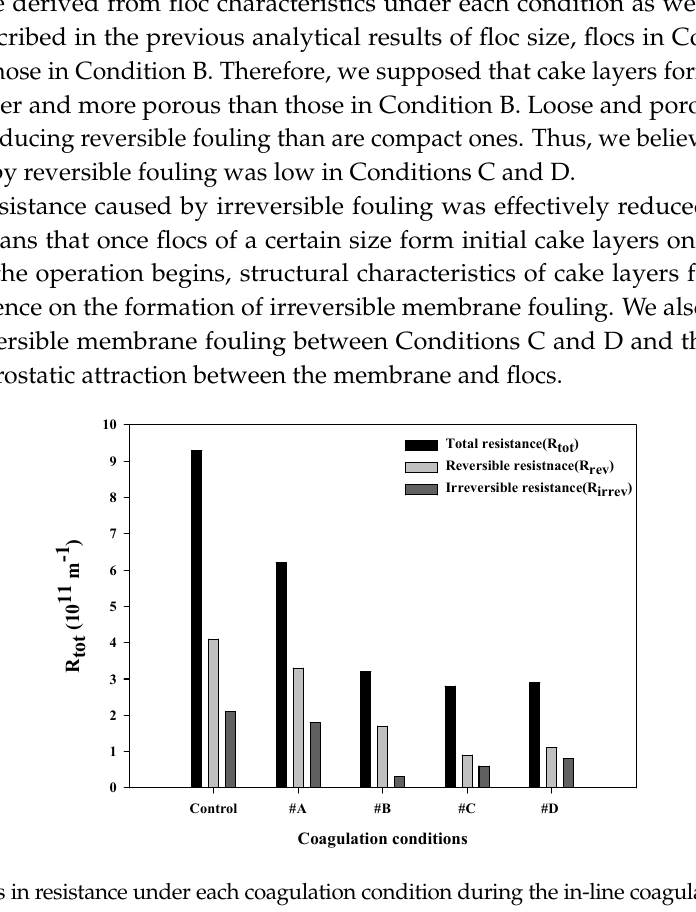
Figure 4. Changes in TMP‐based on increase in operating time under each coagulation condition during the in‐line coagulation/UF process: ( a ) raw water; ( b ) Conditions A and B; ( c ) C and D.